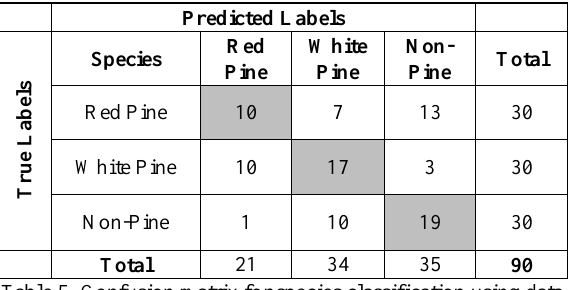
Table 5. Confusion matrix for species classification using data